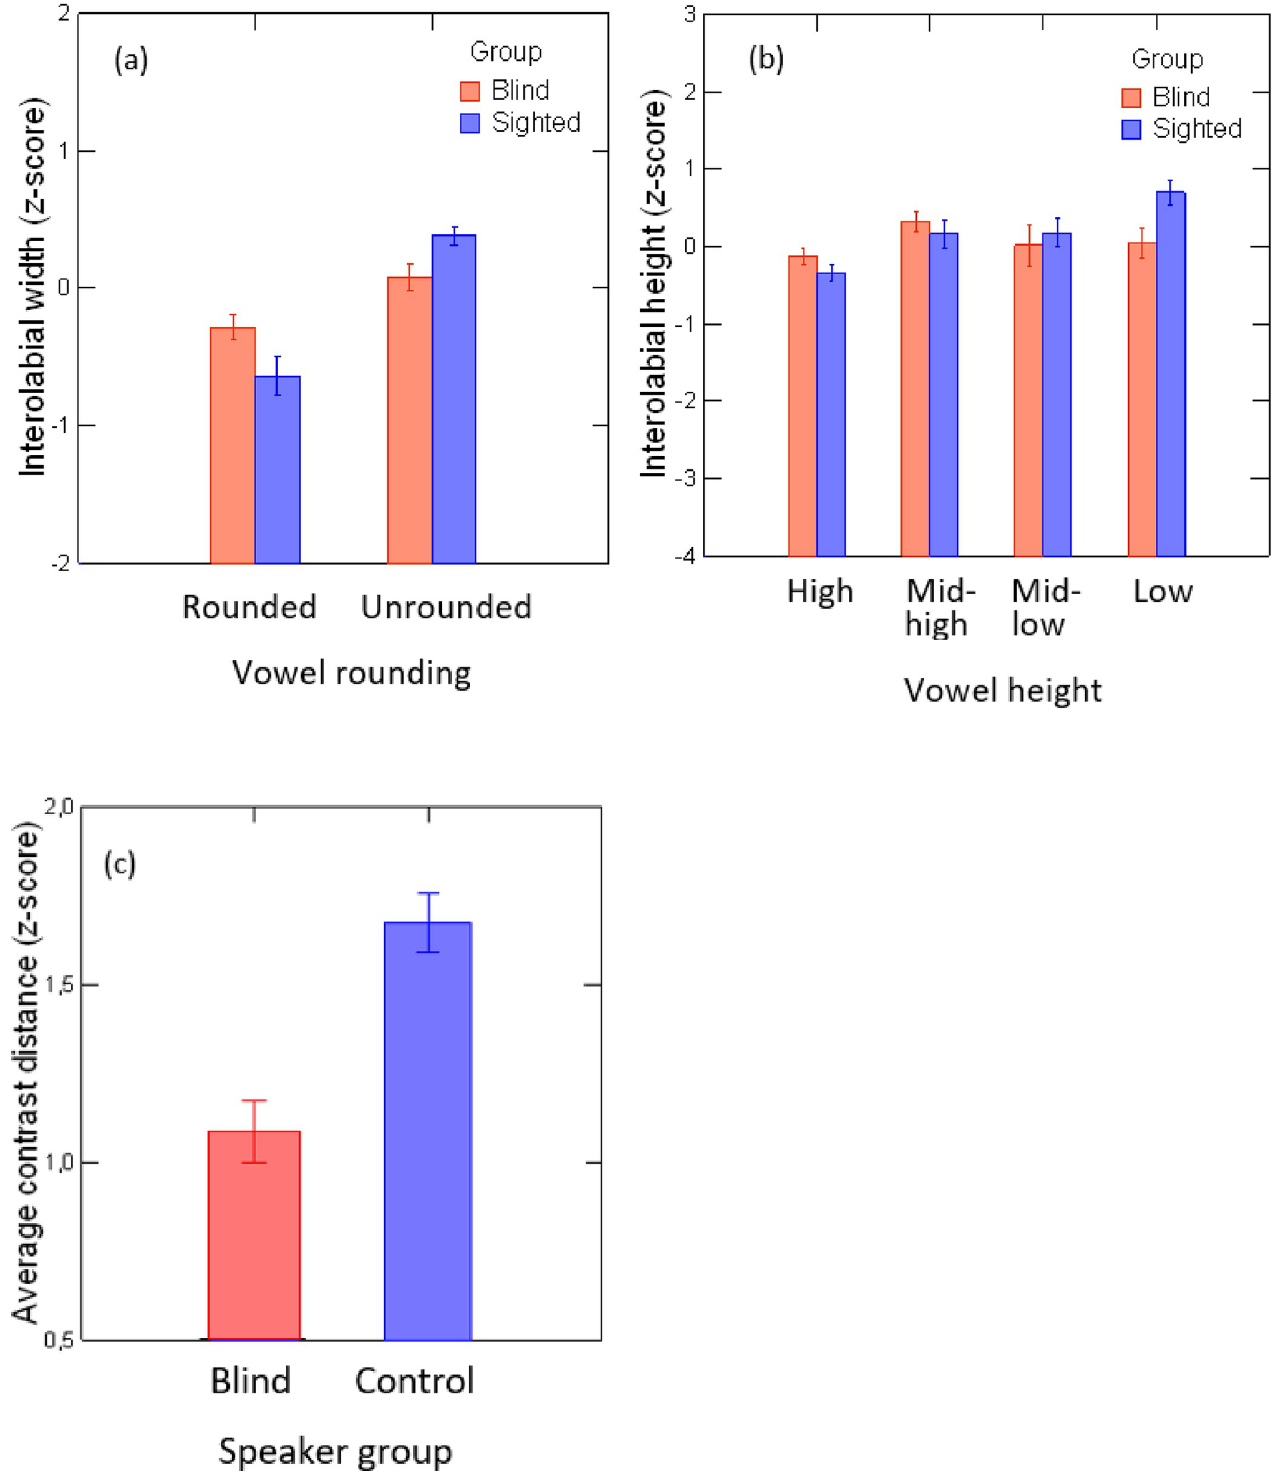
Fig 2. Articulatory and acoustic characteristics of vowel stimuli produced by blind and sighted speakers: Average values of interolabial width (a) and height (b) and average contrast distance (ACD) in the F1 vs. F2 space (c). All data were z-scored. Error bars are standard errors.